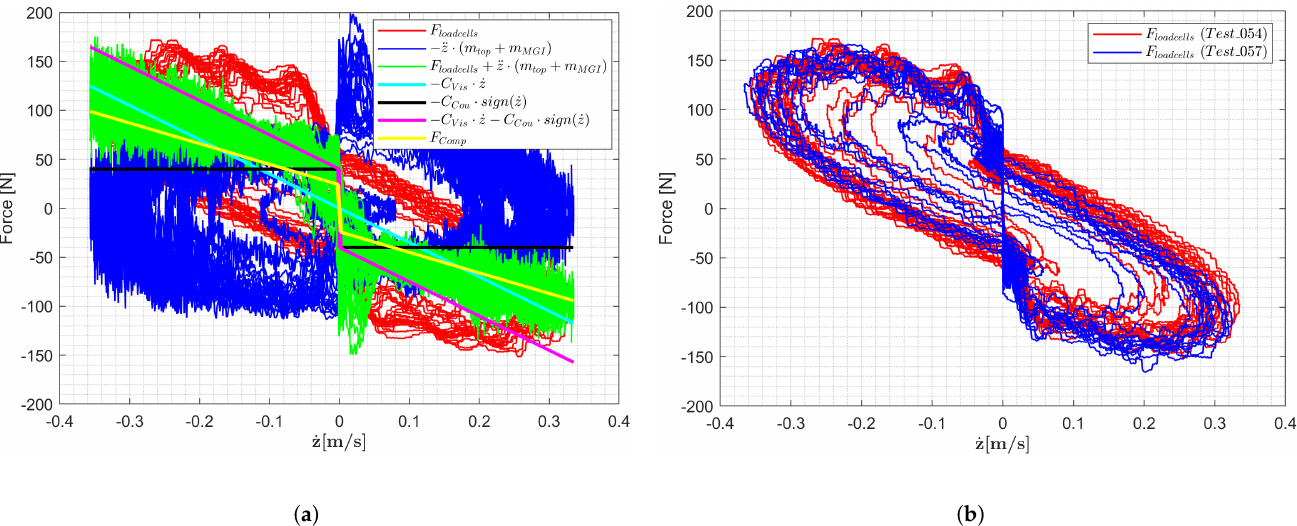
Figure 8. Force to velocity mapping from the WEC friction characterization tests: ( a ) No lateral loading (Test_054); ( b ) No lateral loading (Test_054) versus − 20 kg lateral loading in the x-direction (Test_057). Table 2. C Vis , C Cou , C C and ˙ z Bou for the resulting F Comp